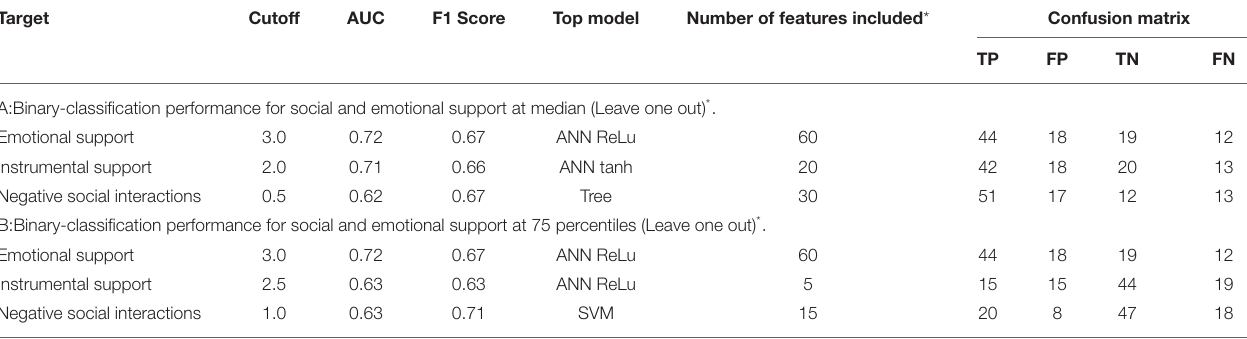
TABLE 3 | Binary-classification performance for social and emotional support at median and 75 percentile (Leave one out) * . Target